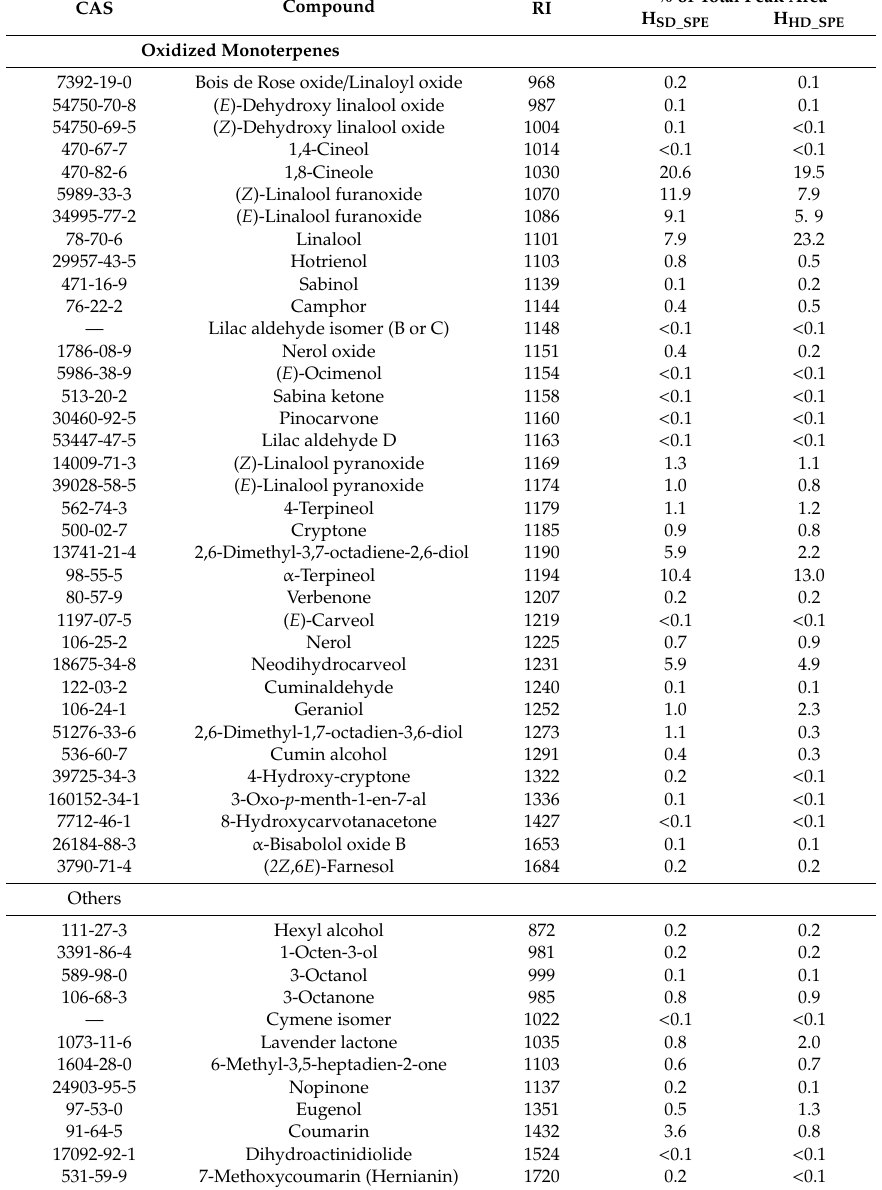
Table 2. List of compounds identified in hydrolate extracts from Lavandula angustifolia